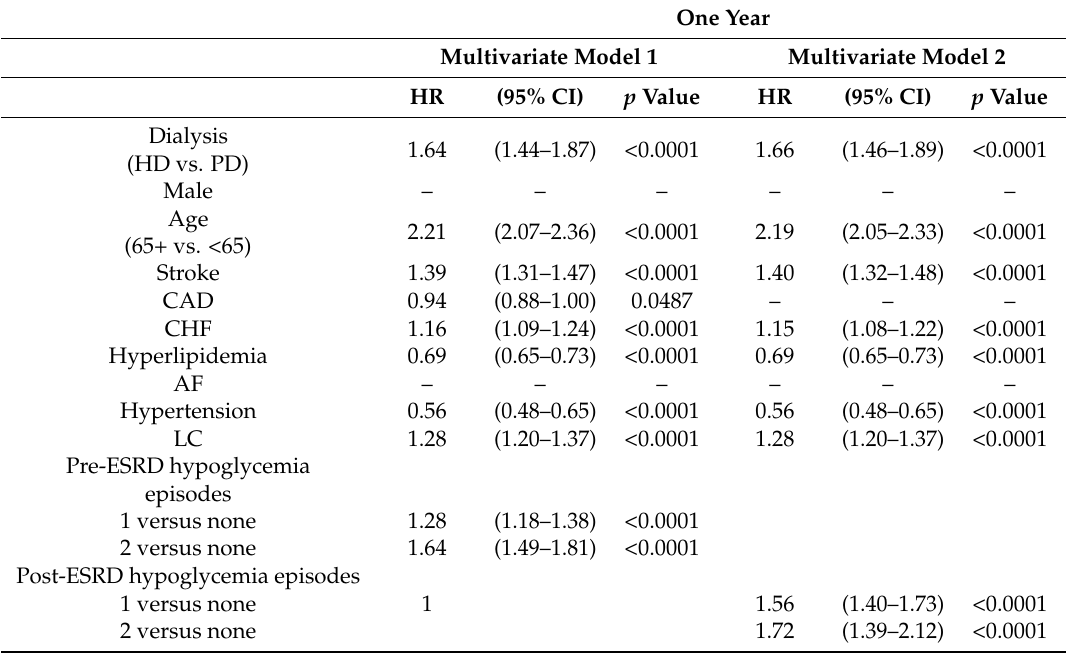
Table 3. Risk factors of one-year mortality among DKD patients transitioning to